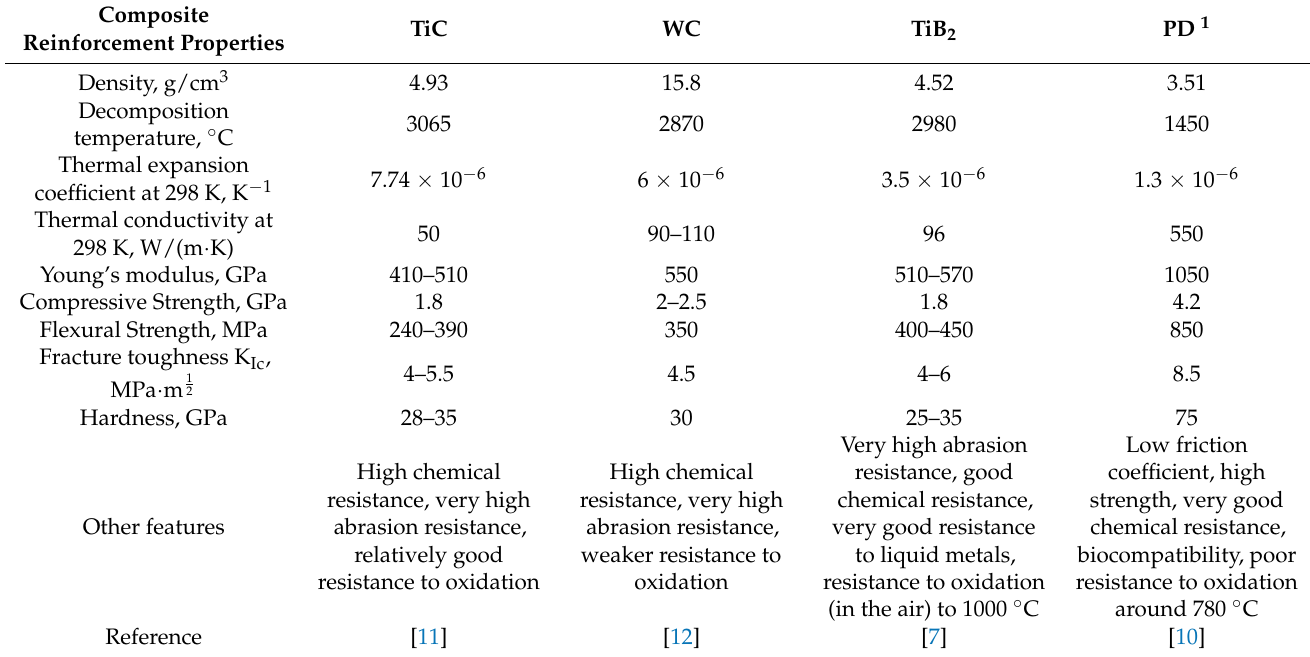
Table 1. Properties of ceramic materials used to reinforce the metal matrix in surfaced composite